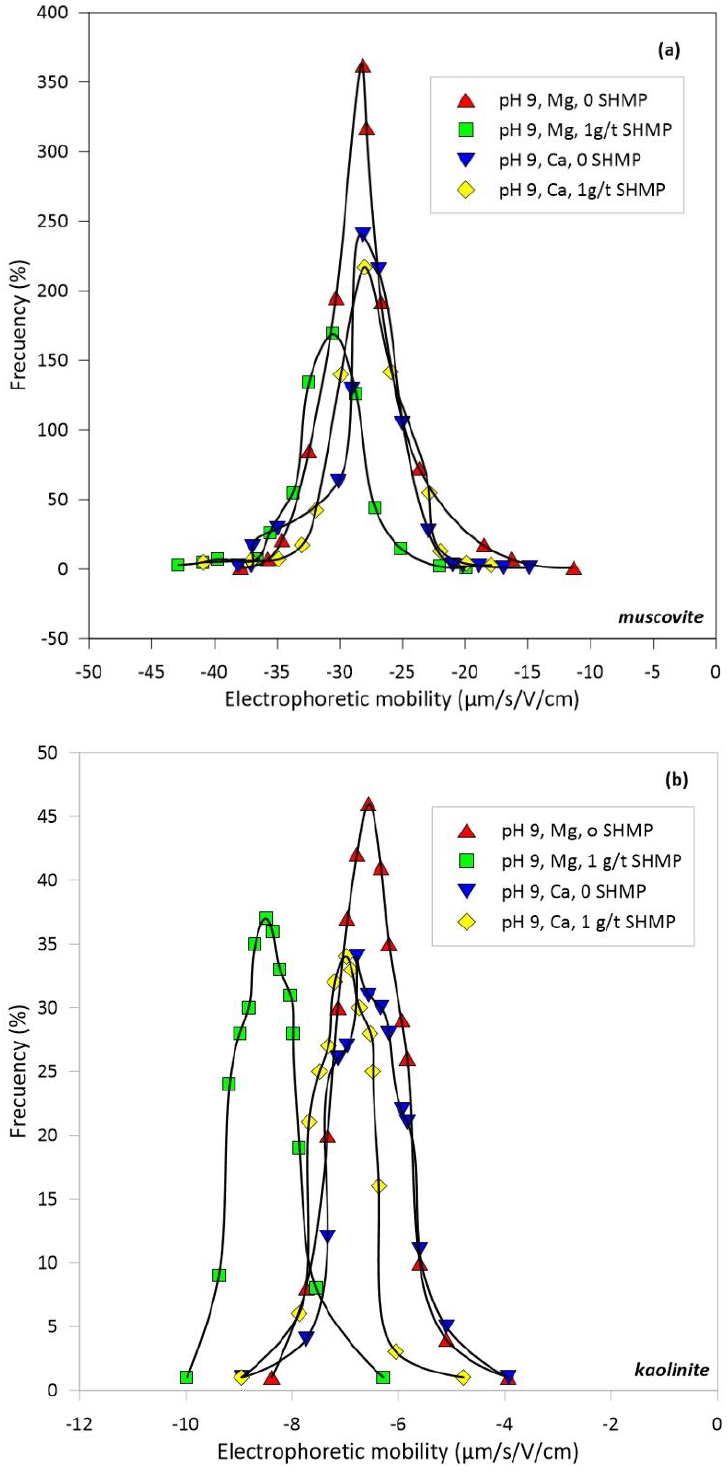
Figure 5. Electrophoretic mobility for muscovite ( a ) and kaolinite ( b ). pH 9, effect of Mg (0.05 M), Ca (0.05 M), and SHMP (1 g/t).